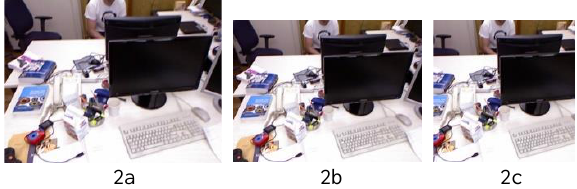
Figure 2 . Schematic diagram of PoseNet image preprocessing.